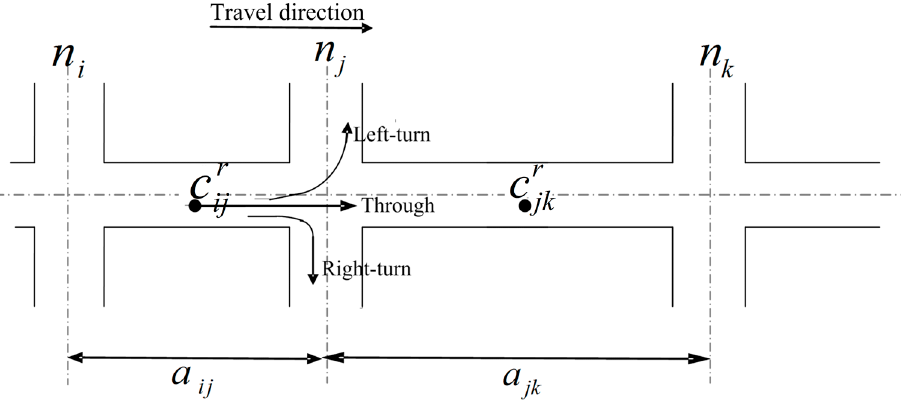
Figure 1. An illustrative example of road network.